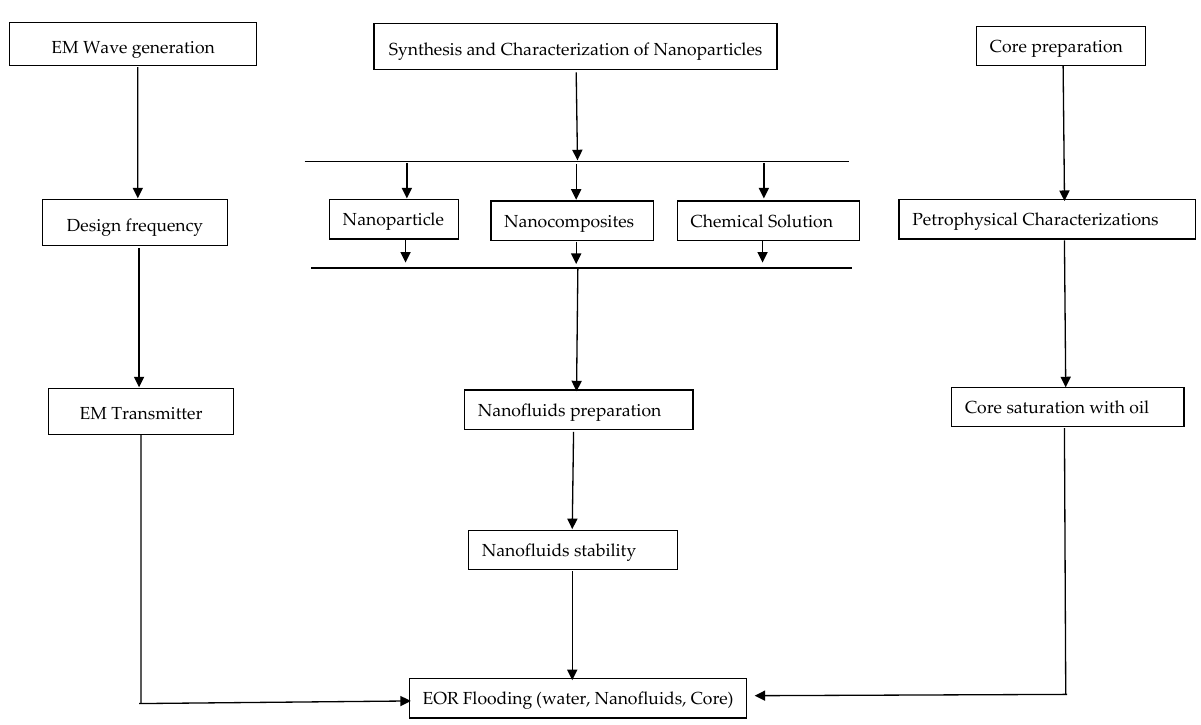
Figure 7. Flow chart of EOR experimental Fig. 7: Flow chart of EOR Experimental procedure